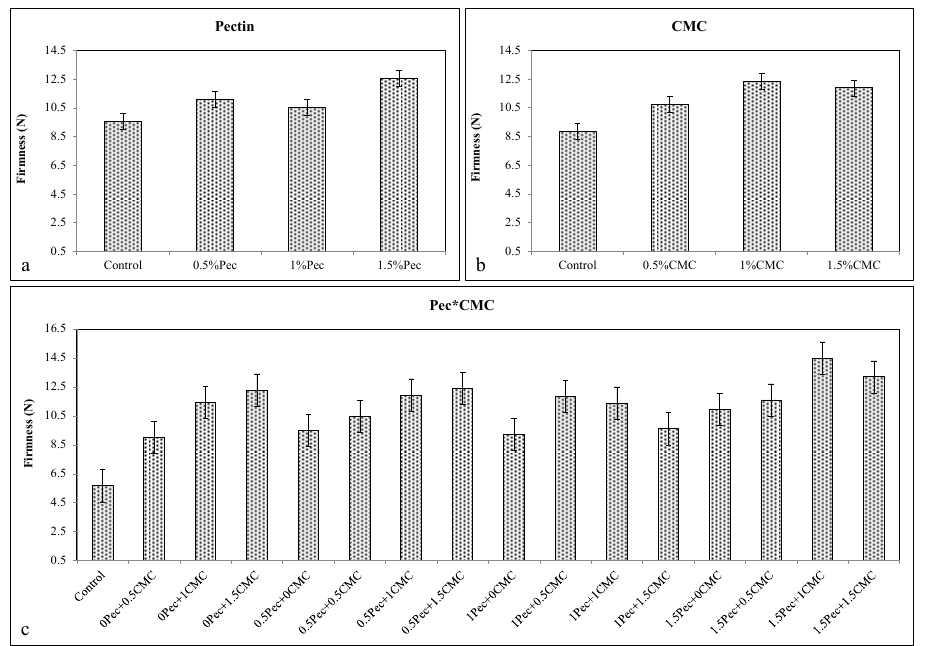
Figure 2. Effect of 0 (control), 0.5 (0.5% Pec), 1 (1% Pec) and 1.5 (1.5%Pec) % pectin-based edible coatings ( a ), 0 (control), 0.5 (0.5% CMC), 1 (1% CMC) and 1.5 (1.5% CMC) % carboxymethylcellulose-based edible coatings ( b ) and their combinations ( c ) on firmness during cold storage period. Data are the “estimated marginal means ± 95% confidence intervals”. The columns with non-overlapping error bars are significantly different ( p ≤ 0.05).